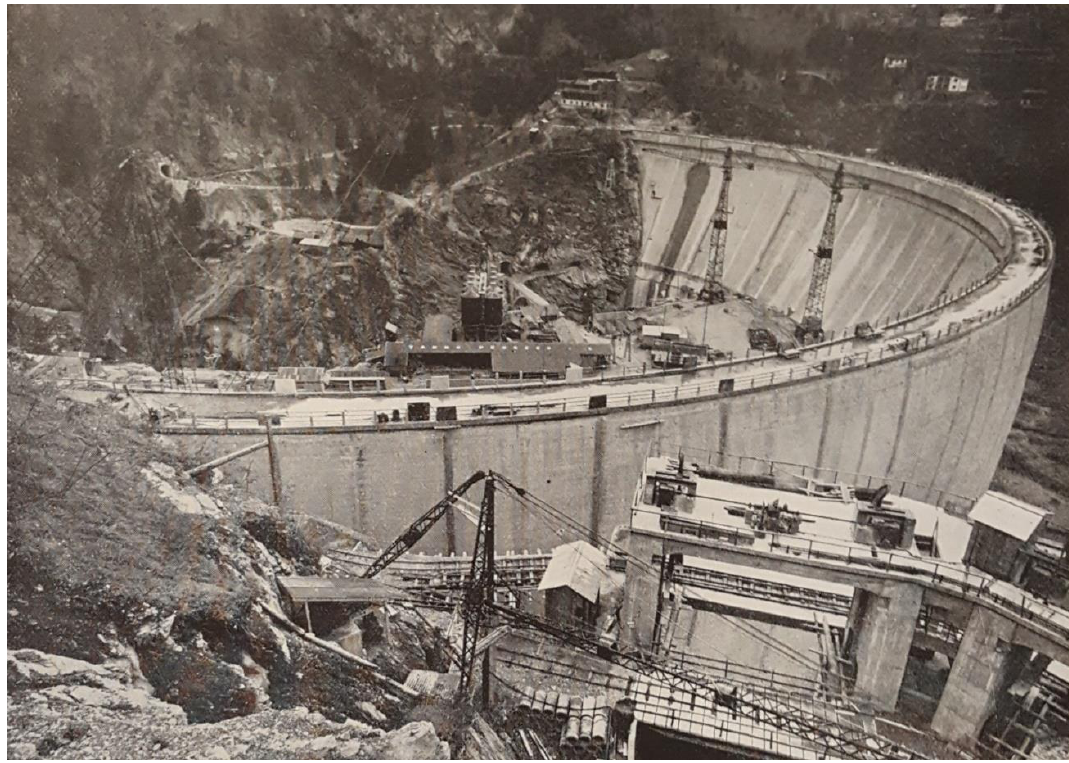
Figure 4. Construction of Pieve di Cadore Dam—Italy [5].